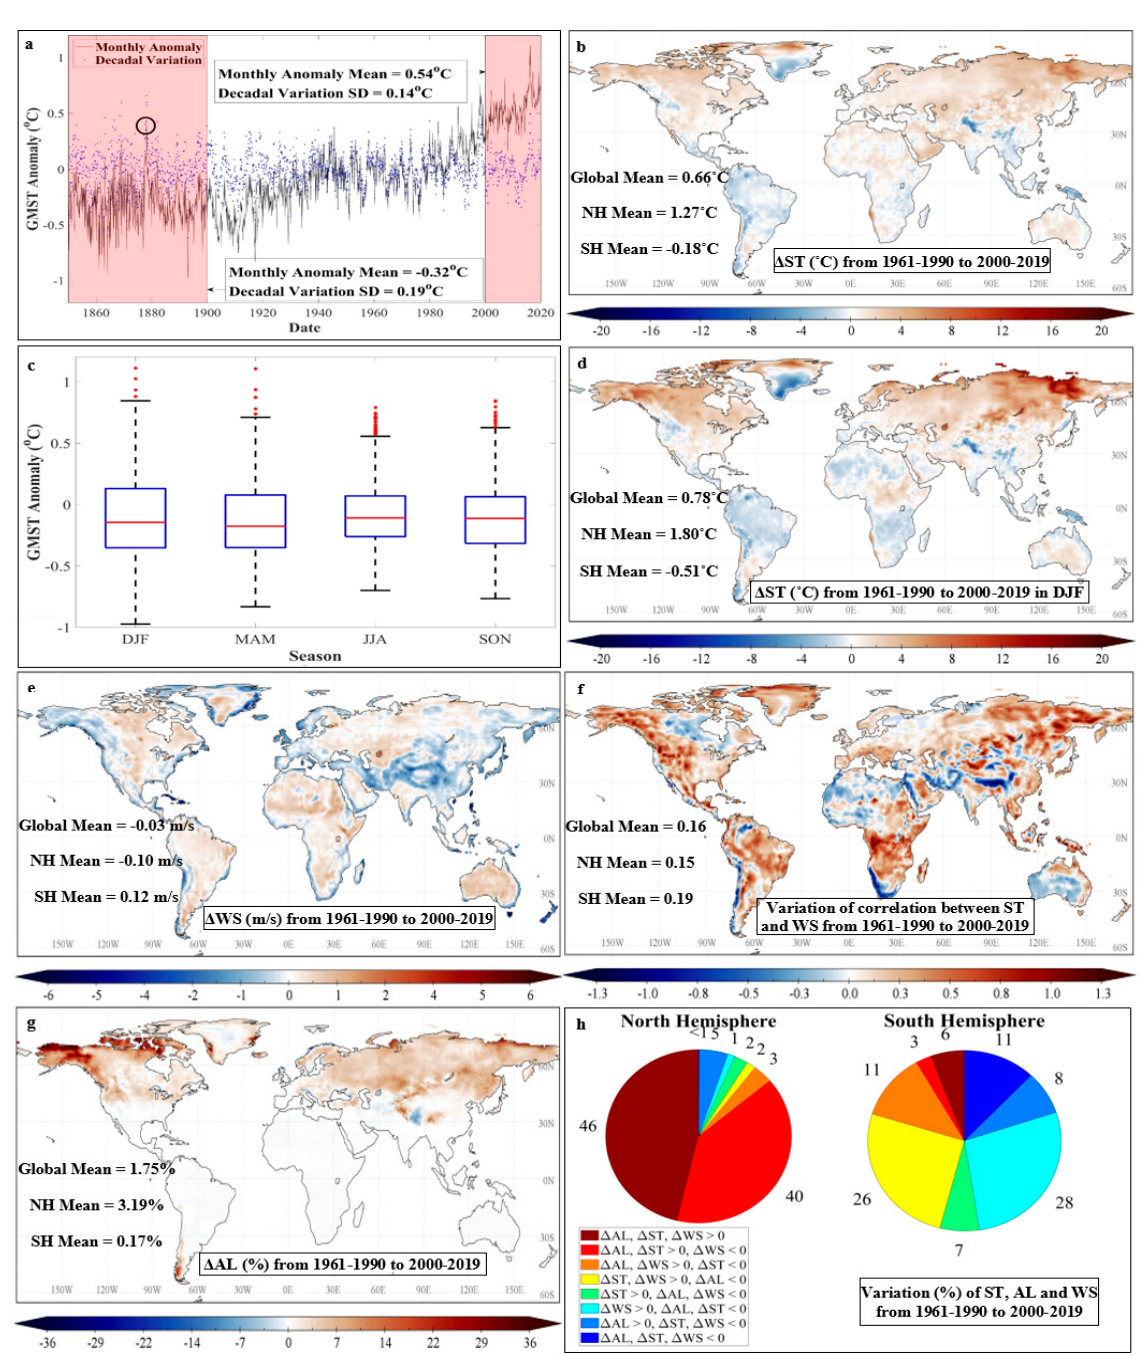
Figure 1. ( a ); Time series of monthly and decadal GMST anomalies. The 1850–1899 and 2000–2019 periods are shown by pink colors to compare the variations before the 20th century and after the 21st century, ( b ); variation of the GMST, ( c) ; boxplots of the GMST anomalies. The horizontal line within the box indicates the median (50% percentile). The upper and lower edges of the box represent the 75% and 25% percentile, respectively. The upper and lower ends of the whiskers represent the maximum and minimum values. Outliers are observations beyond the end of the whiskers, ( d ); variation of the GMST in DJF, ( e ); variation of WS, ( f ); variation of the correlation between the GMST and WS, ( g ); variation of AL, ( h ); Hemispheric variation of the GMST, AL and WS. ( a , c ) are plotted based on the HadCRUT-version 4.6 product [20]. ( b , d – h ) are drawn based on the GLDAS (1 ◦ × 1 ◦ spatial resolution and monthly temporal resolution) dataset